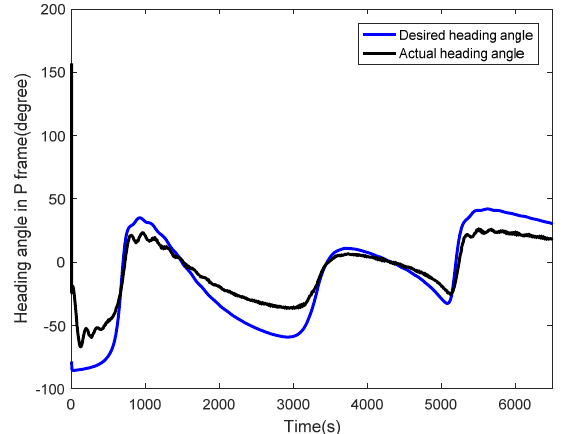
Figure 8. Desired heading angle and actual heading angle.